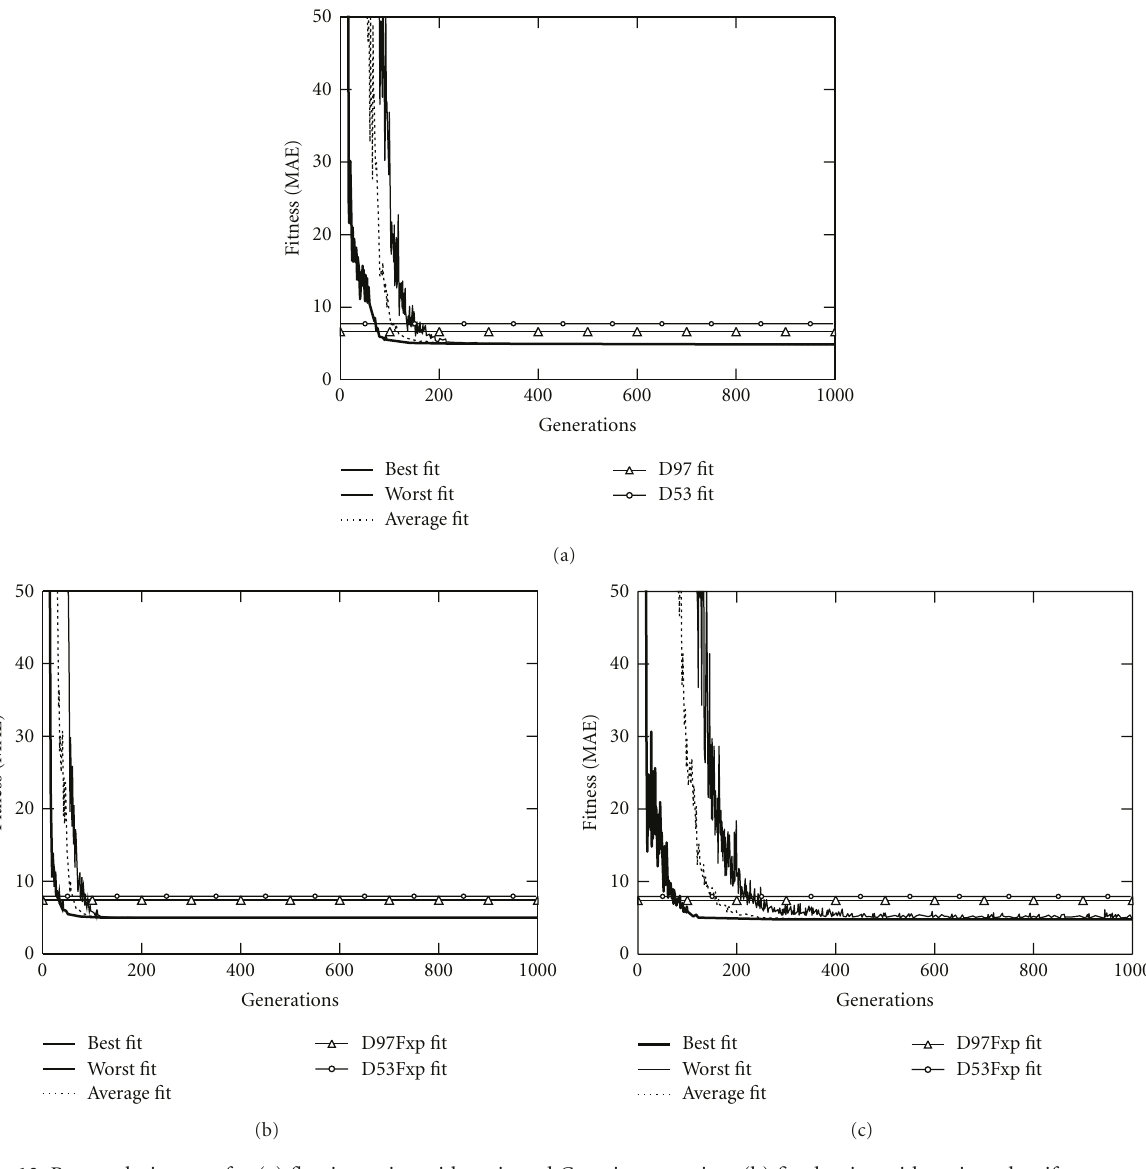
Figure 12: Best evolution run for (a) floating point arithmetic and Gaussian mutation; (b) fixed point arithmetic and uniform mutation, comma selection; (c) fixed point arithmetic and uniform mutation, plus selection.